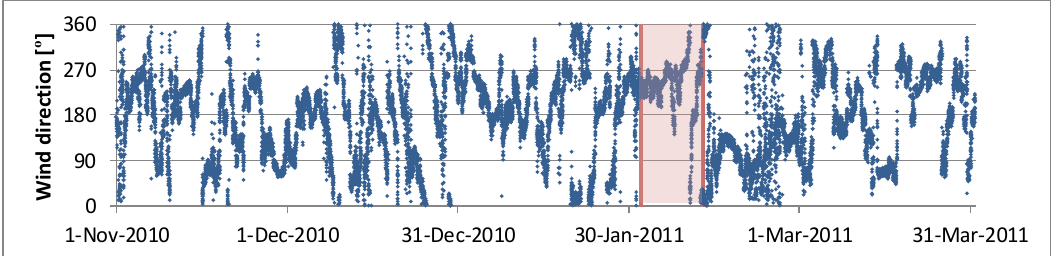
Figure 5. Wind speed and direction measured at Frombork in the winter season 2010/2011; the pink rectangle indicates the calibration period (1 February – 12 February); data from https://dane.imgw.pl/. Table 1. Distribution of wind directions in percent during the winter season 2010/2011 recorded in Frombork with respect to four speed ranges; data from https://dane.imgw.pl/. Wind Directions (%) Wind Speed (m / s)